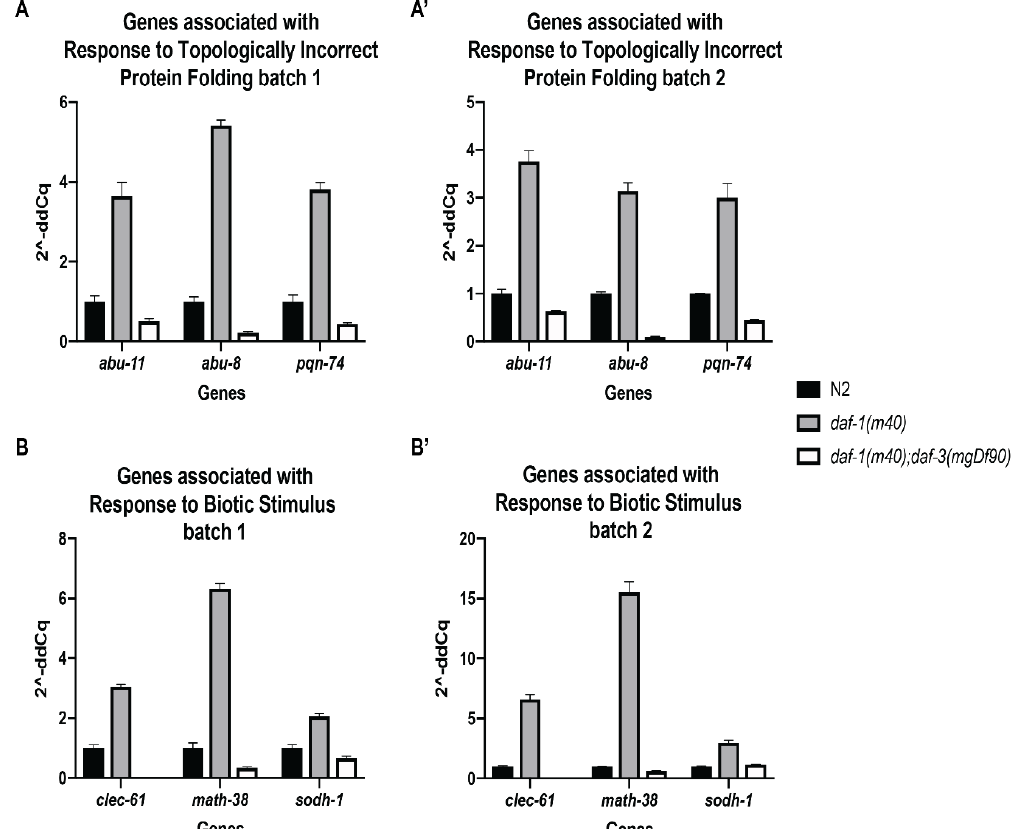
Figure 4. qPCR validation of select genes from the RNA-seq dataset. ( A ) Expression fold change for three Response to Topologically Incorrect Protein Folding genes. ( A’ ) Biological replicate of A. ( B ) Expression fold change for three Response to Biotic Stimulus genes. ( B’ ) Biological replicate of B. For all qPCR analysis, cDNA was synthesized from 1µg of total RNA. qPCR was performed using 2 µL of cDNA per reaction with gene specific primers and cdc-42 as the endogenous control. Error bars represent standard deviation of technical triplicates.